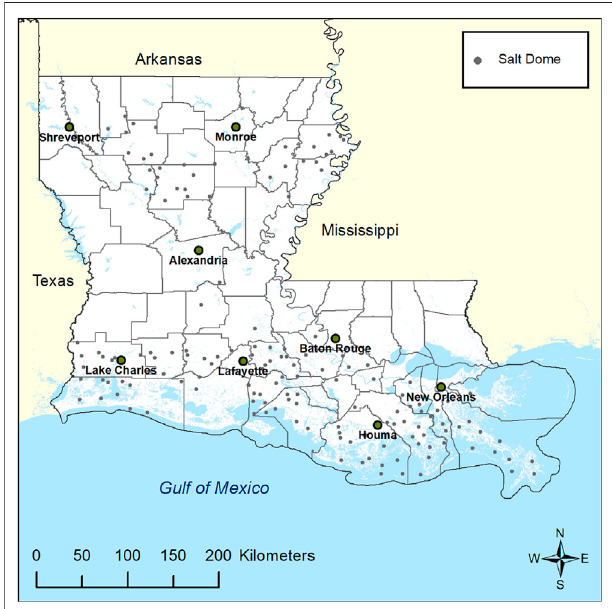
FIGURE 1 | Terrestrial salt domes in Louisiana. Source: Derived from Beckman and Williamson (1990).